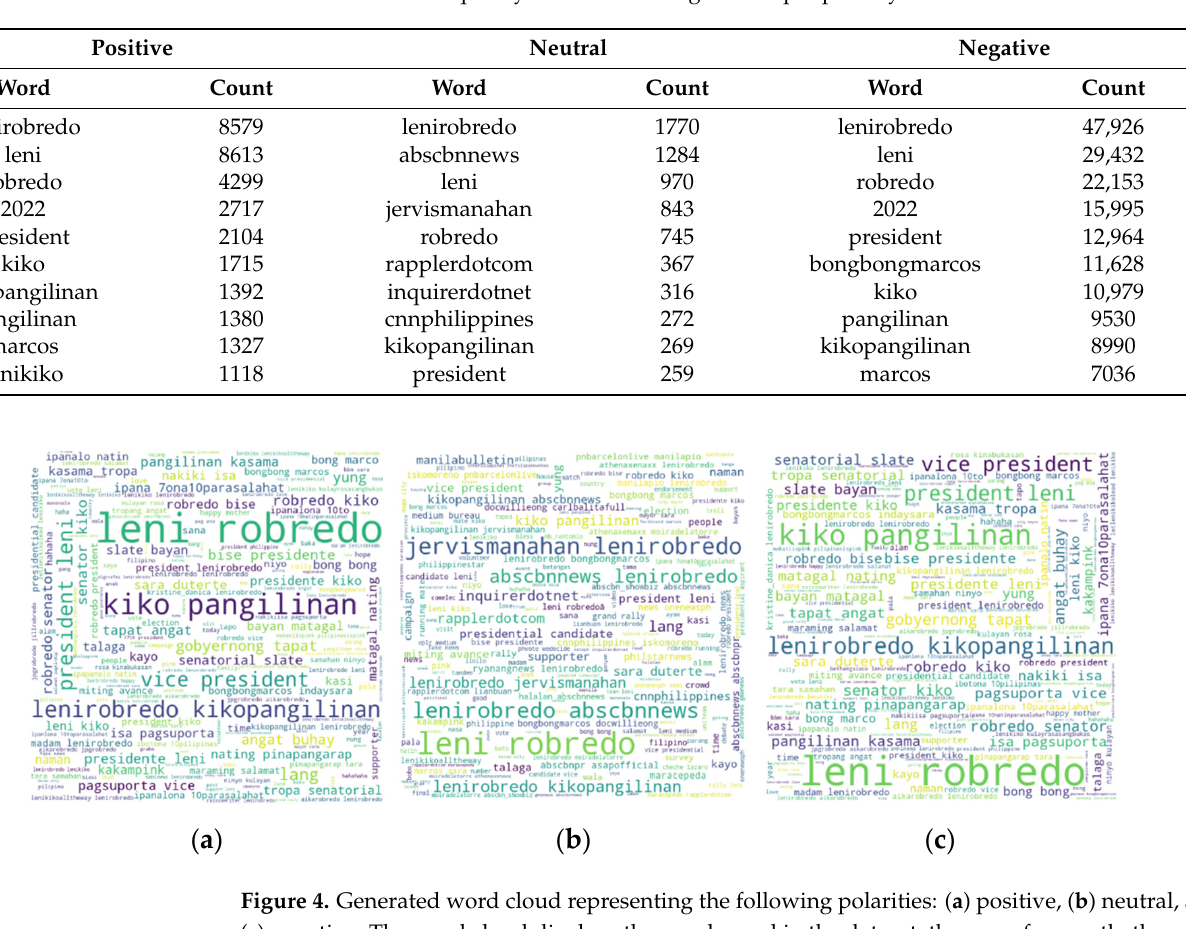
Table 9. The word frequency from the training dataset per polarity.